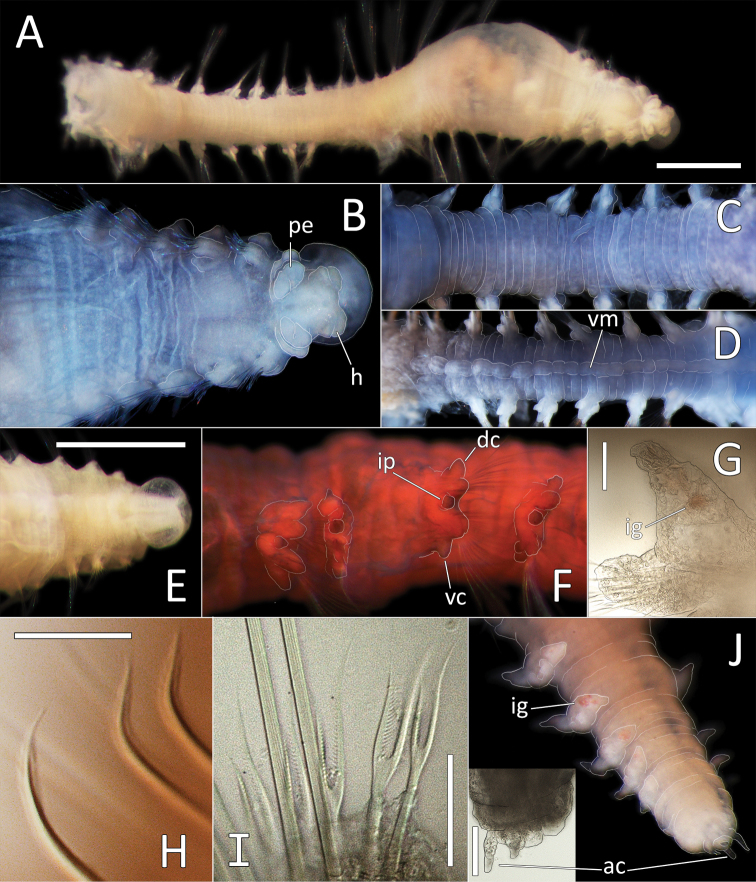
Oligobregma
brasierae sp. nov. A Lab image, whole specimen (holotype [specimen NHM_823], pre-staining) B Lab image, dorsal anterior (holotype, faded stain, h = prostomial horns, pe = peristomial ring) C Lab image, dorsal segments, quadriannulate chaetigers (holotype, faded stain) D Lab image, ventral segments (holotype, faded stain, vm = ventral midline) E Lab image, ventral anterior, (holotype, pre-staining) F Lab image, mid-body parapodia (holotype, shirlastained, dc = dorsal cirrus, vc = ventral cirrus, ip = interramal papilla) G Lab image, detail of dorsal cirrus (paratype NHM_684, ig = internal gland) H Lab image, detail of hirstute notopodial spines on chaetiger 1 (paratype NHM_684, ig = internal gland) I Lab image, detail of capillary and lyrate chaetae (paratype NHM_684) J Lab images, posterior (paratype NHM_684, [bottom-left panel], ac = anal cirri, ig = internal gland). Morphological features in plates B–D, F, G, H have been outlined with a fine white or black line to improve clarity of those features. Scale bars: 1 mm (A, E); 50 μm (G); 25 μm (H, I); 100 μm (J).